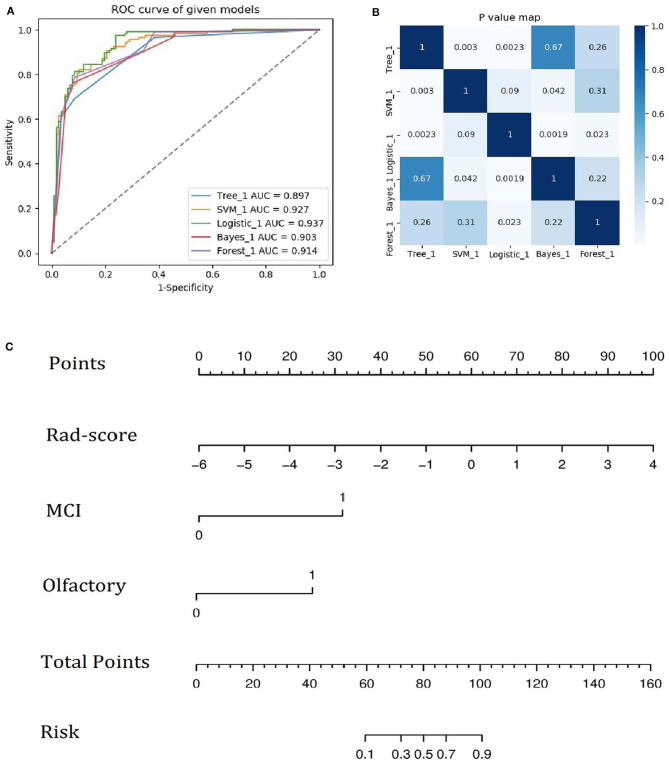
(A) ROC curves of the five machine learning methods. (B) Heatmap of p-values obtained using the model compared with each of the other machine learning methods based on the DeLong test. (C) Integrative nomogram used to detect PD. The nomogram was developed using the training set. In the nomogram, a vertical line is first generated according to the value of the rad-score to determine the corresponding score. Similarly, the scores for CD and olfaction are also determined. Then, the total score is calculated as the sum of the three scores described above. Finally, a vertical line is generated according to the value of the total score to determine the probability of PD.